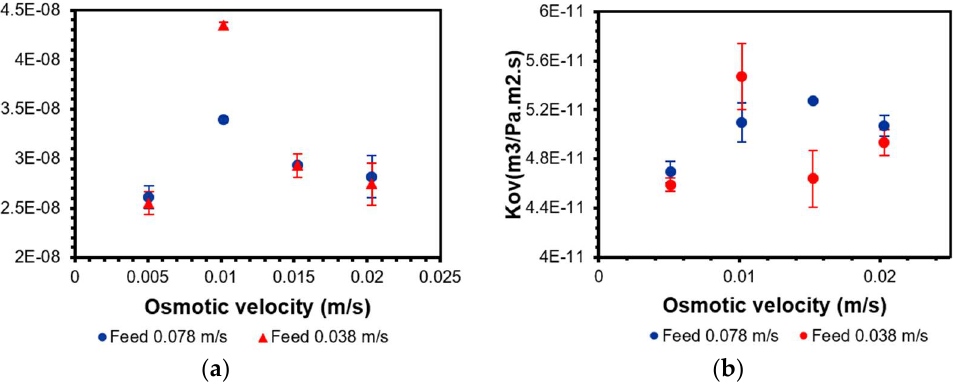
Figure 4. ( a ) Flux for changes in osmotic flow rate. ( b ) K ov for changes in osmotic flow rate. The concentration of NaHCO 3 was at a maximum, and the feed and osmotic solutions were at room temperature.